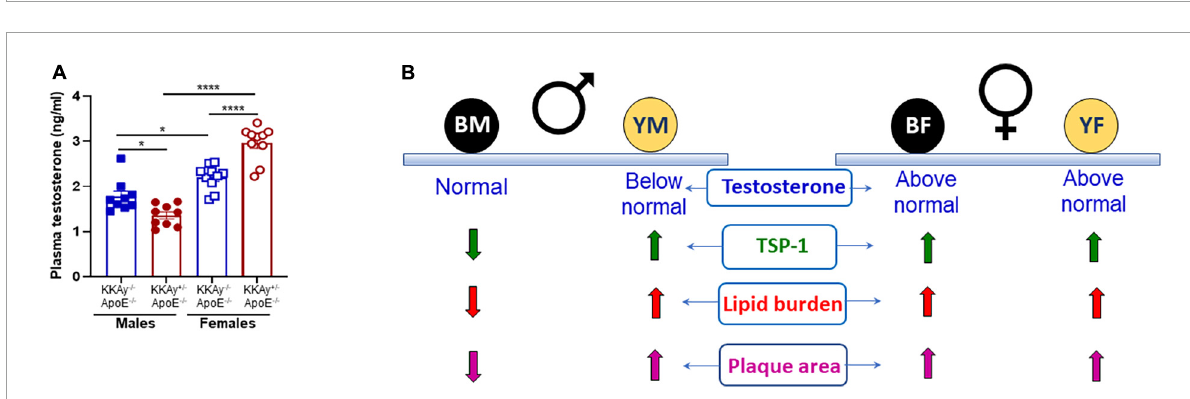
FIGURE8 Sex-specific differences in plasma testosterone levels in MetS KKAy + / − ApoE − / − and non-MetS KKAy − / − ApoE − / − mice. (A) Shown are summary graphs for plasma testosterone levels in 24-weeks-old male and female MetS KKAy + / − ApoE − / − and non-MetS KKAy − / − ApoE − / − mice. * p < 0.05; **** p < 0.0001 ( n = 9–10 mice per genotype per sex). (B) Overview of findings. BM, black male KKAy − / − ApoE − / − ; YM, yellow male KKAy + / − ApoE − / − ; BF, black female KKAy − / − ApoE − / − ; YF, yellow female KKAy + / − ApoE − / − .